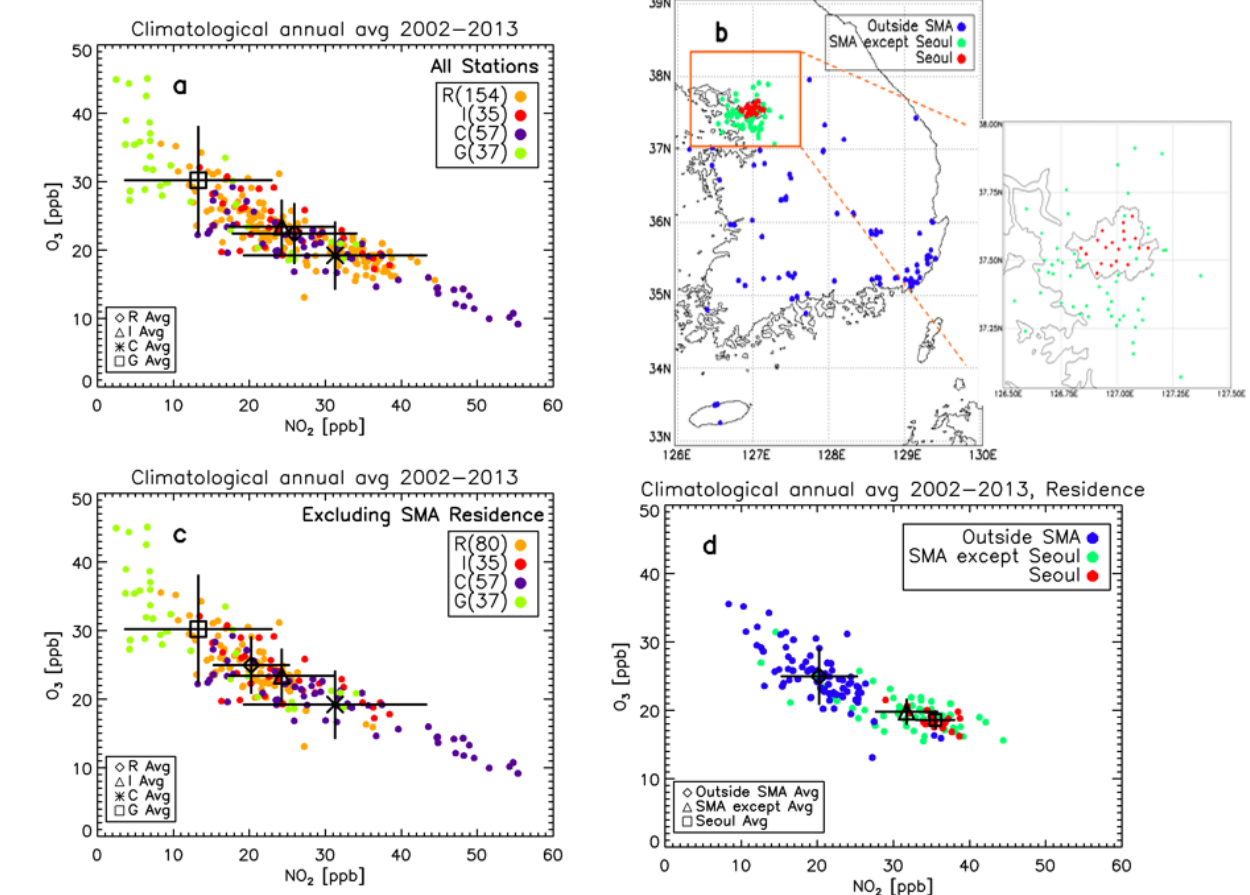
Figure 9. Climatological annual averages of the O 3 (ppb) versus NO 2 (ppb) over South Korea during 2002–2013 under the MEK four land- use types of residence (R), commerce (C), industry (I), and greenbelt (G). (a) O 3 versus NO 2 at all 283 stations in South Korea. The number in the upper-right-side panel of the figure indicates the number of stations. (b) Locations of 154 “residence-type” stations subdivided by the three regions as follows: (i) Seoul (red circle), (ii) the Seoul Metropolitan Area (SMA; green circle) except for Seoul, and (iii) outside of the SMA (blue circle). The rectangular area in Fig. 9b indicates that the SMA has been enlarged on the right side. (c) Same as Fig. 9a except for exclusion of the O 3 and NO 2 observations of the SMA residential region. (d) Same as Fig. 9a except for using the O 3 and NO 2 only in the “residence” type under the three different regions of Fig. 9b. The mean values and standard deviations for the annual values of NO 2 and O 3 in each of the types are indicated in Fig. 9a, b, and